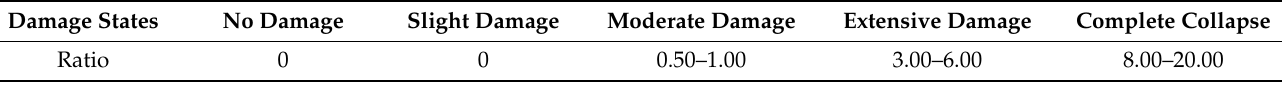
Table 4. Ratio of indirect losses to direct losses.